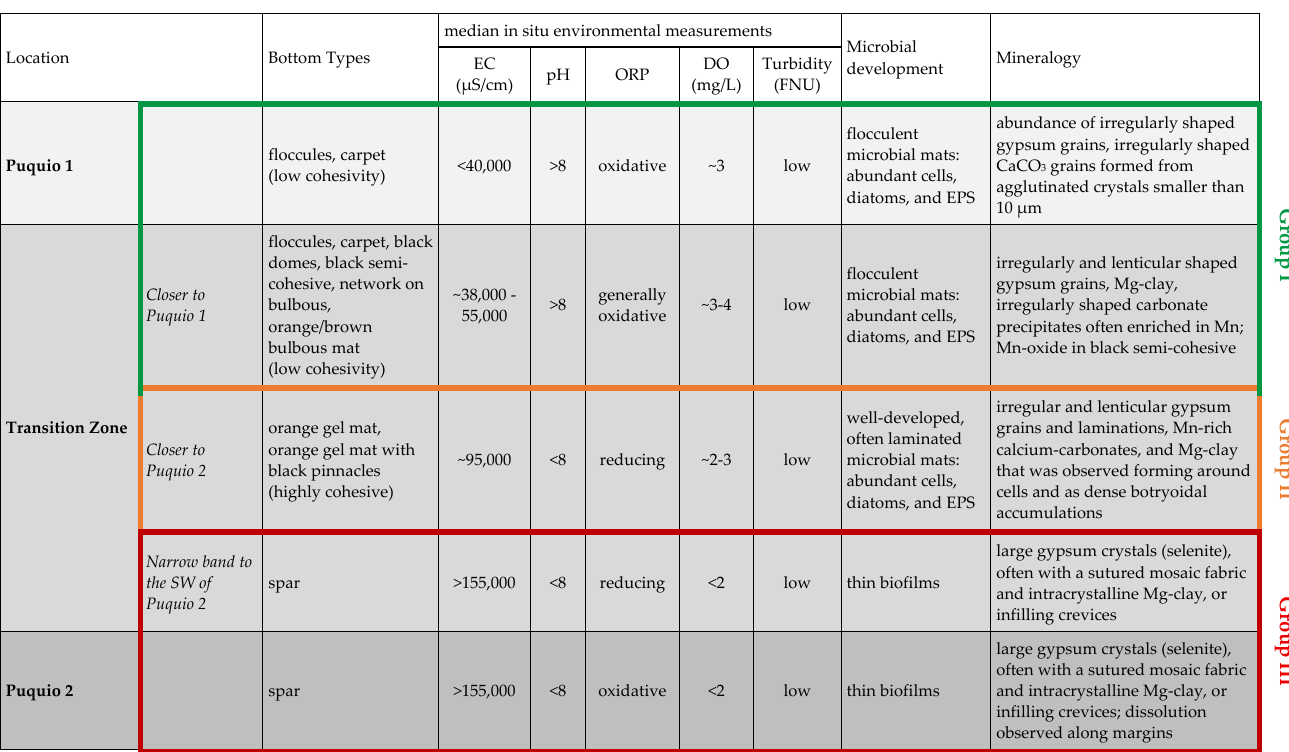
Figure 10. Principal component analysis (PCA) of Group I bottom types (carpet, black domes, black semi-cohesive mat, floccules, network, and orange–brown bulbous mat) using pH, ORP, and DO as variables, showing that the six bottom types in the group are statistically similar. Table 2. Summary table showing bottom type groups (I, II, III) in relation to the group’s location in the P1/P2 subsystem, including the main bottom types, measured environmental parameters, microbial development, and dominant mineralogy.